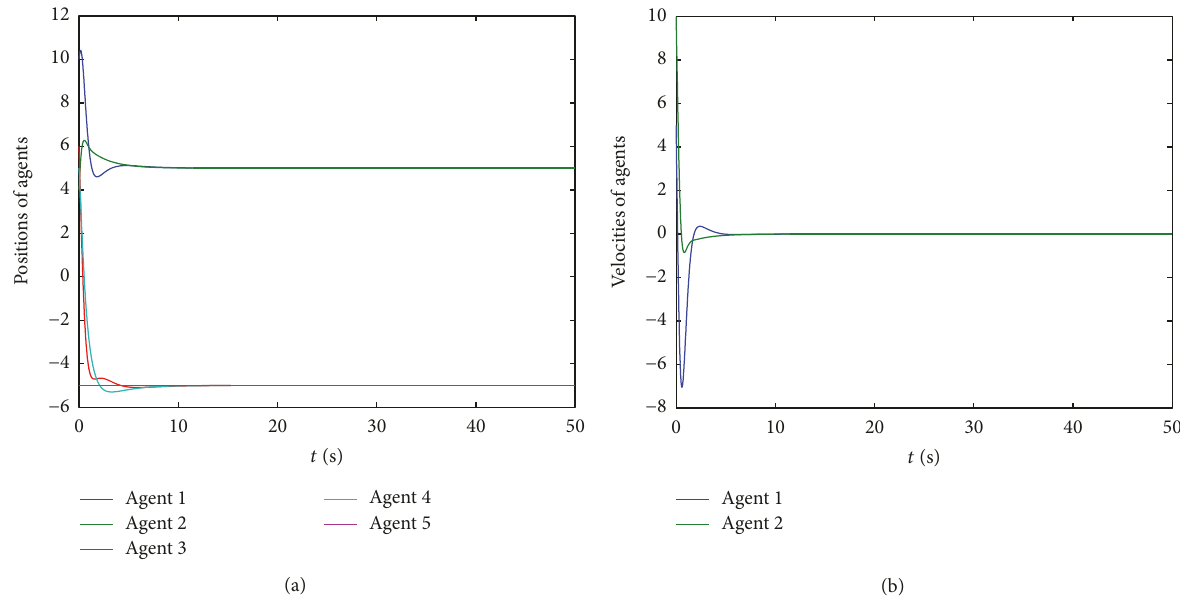
Figure 9: The state trajectories of the agents in systems (18) when 𝜏 = 0.2 s. (a) Position state and (b) velocity